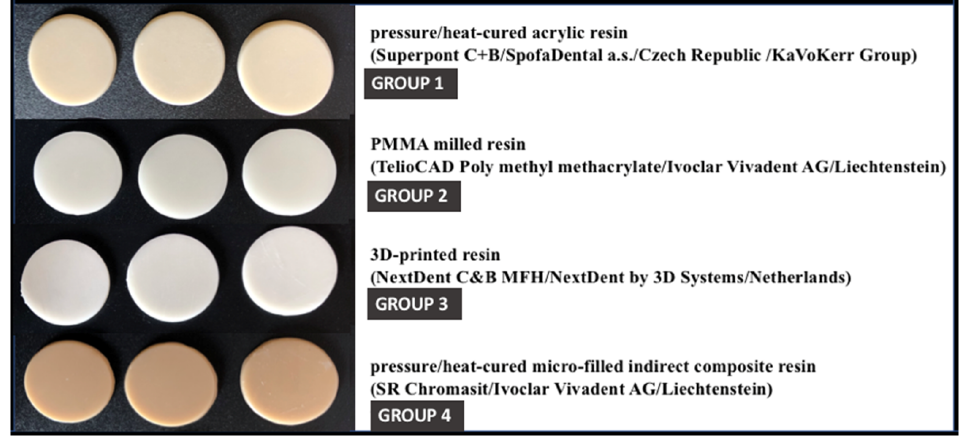
Figure 2. The obtained resin specimens.